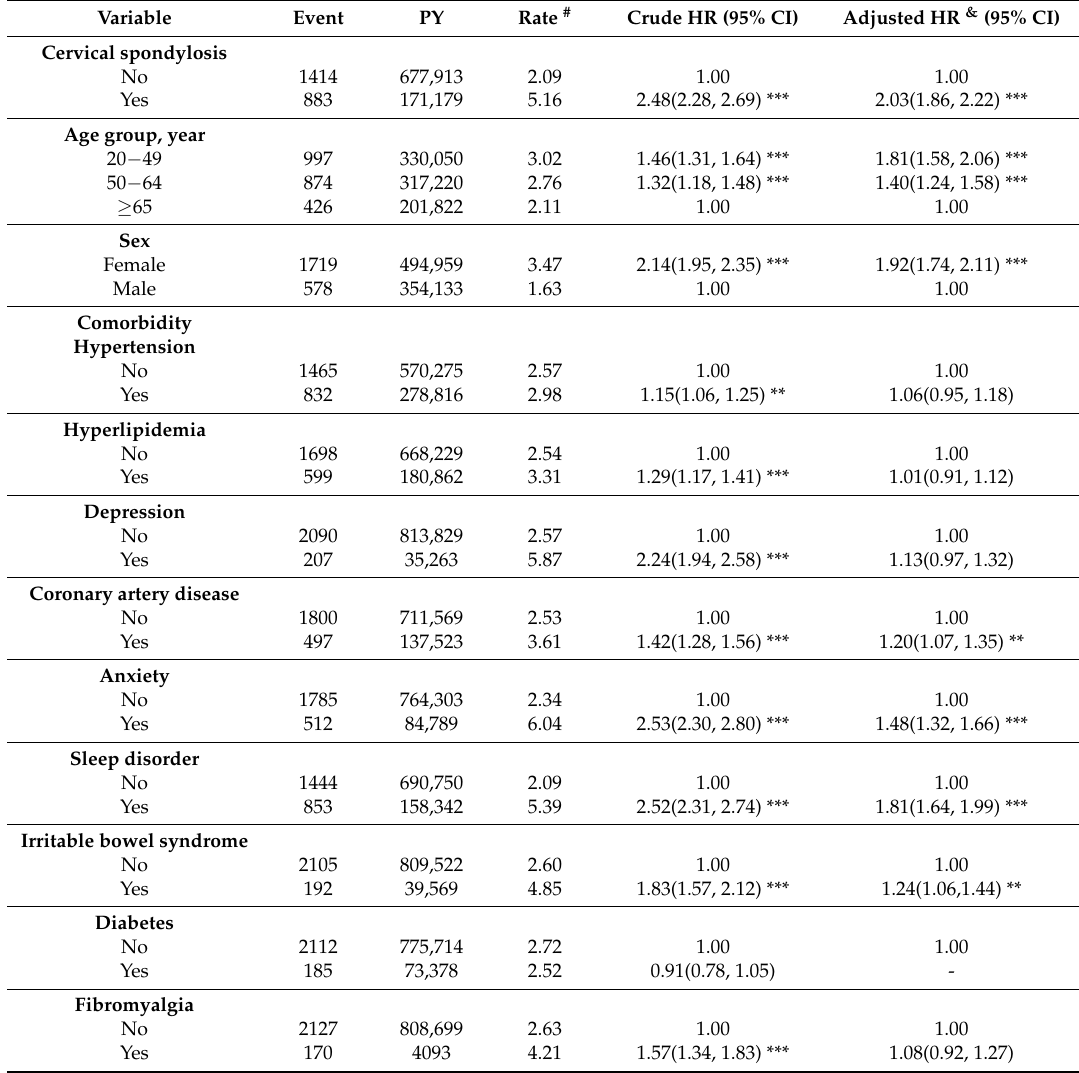
Table 2. Migraine incidences and risk